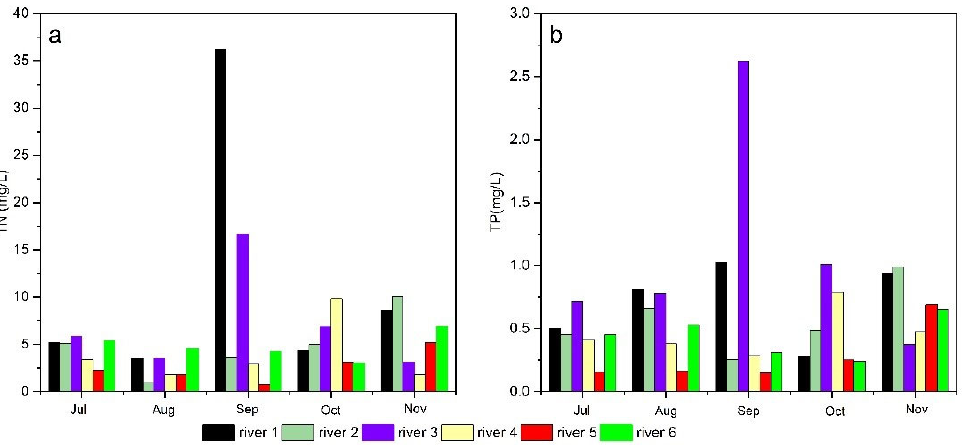
Figure 12. Average TN and TP concentrations in Lake Xingyun inflow rivers in 2017. ( a ) TN. ( b ) TP.